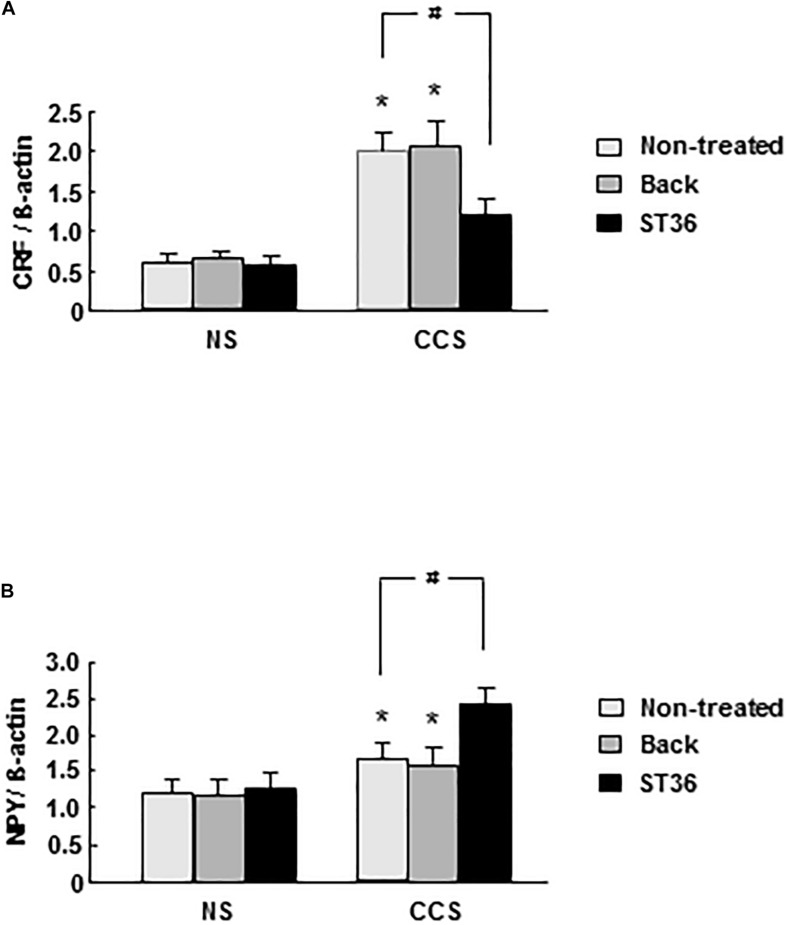
Effects of EA on central CRF
(A) and NPY
(B) mRNA expression in response to CCS. (A) In the non-stressed (NS) groups, both EA at back and at ST-36 had no effect on the CRF mRNA expression. In the CCS groups, CRF mRNA expression increased significantly (non-treated). EA at back did not change the CRF mRNA expression significantly, however, the EA at ST-36 significantly decreased the CRF mRNA expression. (B) In the NS groups, both EA at back and at ST-36 had no effect on the NPY mRNA expression. In the CCS groups, NPY mRNA expression increased significantly. EA at back did not change the CRF mRNA expression significantly, however, the EA at ST-36 further significantly increased the NPY mRNA expression. The mRNA expression was standardized with the ratio of internal control of β-actin (n = 6, *P < 0.05 compared with NS non-treated group, #P < 0.05 compared with CCS non-treated group).